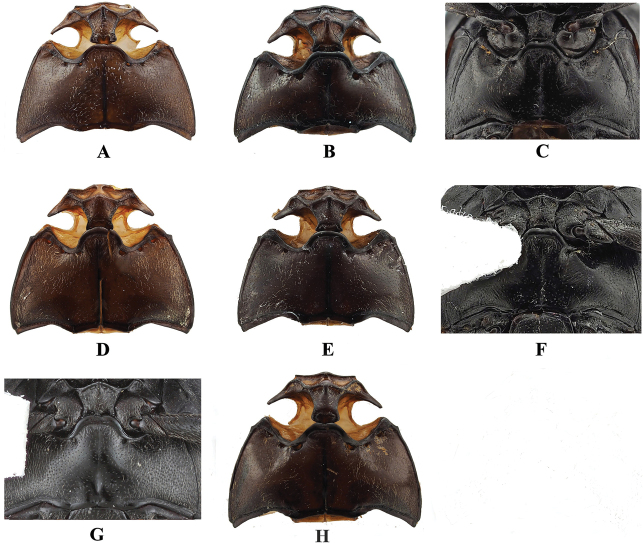
Meso- and metaventrite of Sinocymbachus spp AS.
angustefasciatusBS.
bimaculatusCS.
decorusDS.
excisipesES.
humerosusFS.
luteomaculatusGS.
parvimaculatusHS.
quadrimaculatus.